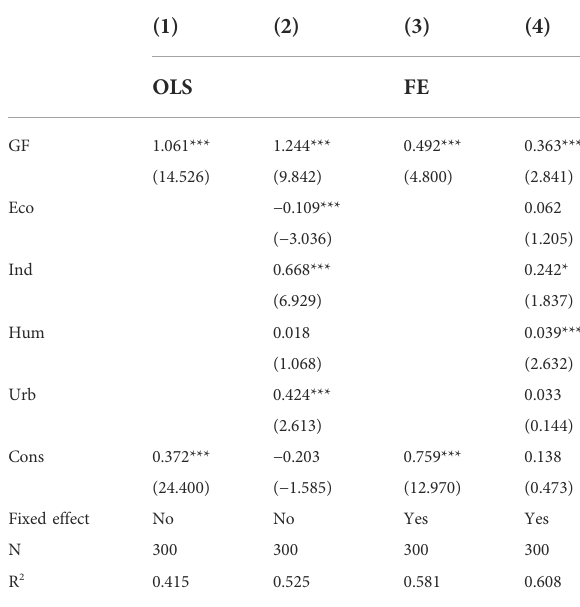
TABLE 1 Descriptive statistical analysis. TABLE 2 Baseline